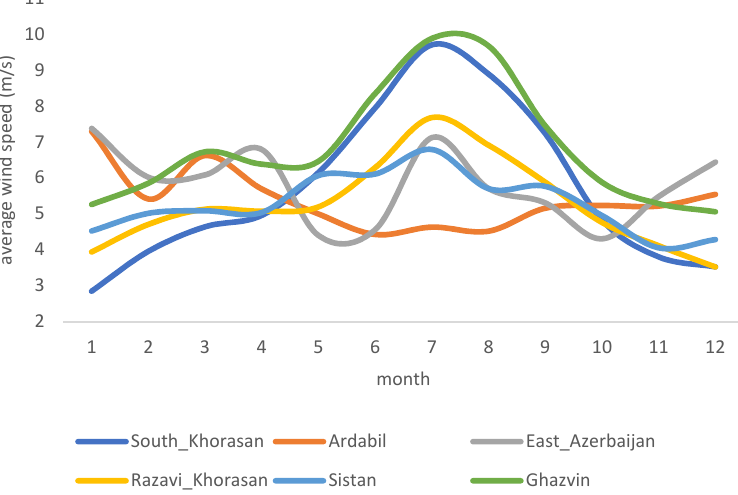
Figure 6. Seasonal variation of wind speed, selected provinces of Iran with annual average wind speeds of larger than 5 m/s. Table 2. Average monthly wind speed at the height of 40 m for six high wind provinces,